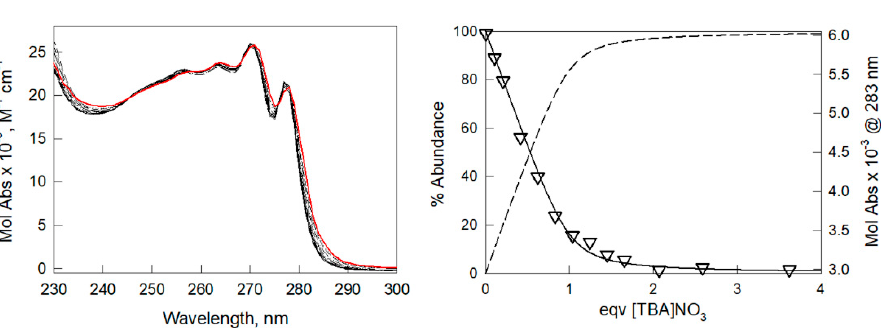
Figure 2. UV-vis. titration of a solution of 1 (PF 6 ) 3 (0.174 mM) in acetonitrile with a 100-fold more concentrated solution of [TBA]NO 3 . On the left: family of spectra taken during titration (red line and black solid lines: initial and final spectra, respectively). On the right: distribution diagram of the species, calculated for an association constant of 5.3 log units (solid line: % of the free 1 3+ cage; dashed line: % of 1:1 complex with nitrate, [ 1 (NO 3 )] 2+ , with the superimposed experimental data (triangles) of the Molar Absorptivity at 283 nm (right-hand y-axis) vs. eqv. of [TBA]NO 3 . The distribution diagram was obtained using the Hyss software (Hyperquad package) [32].